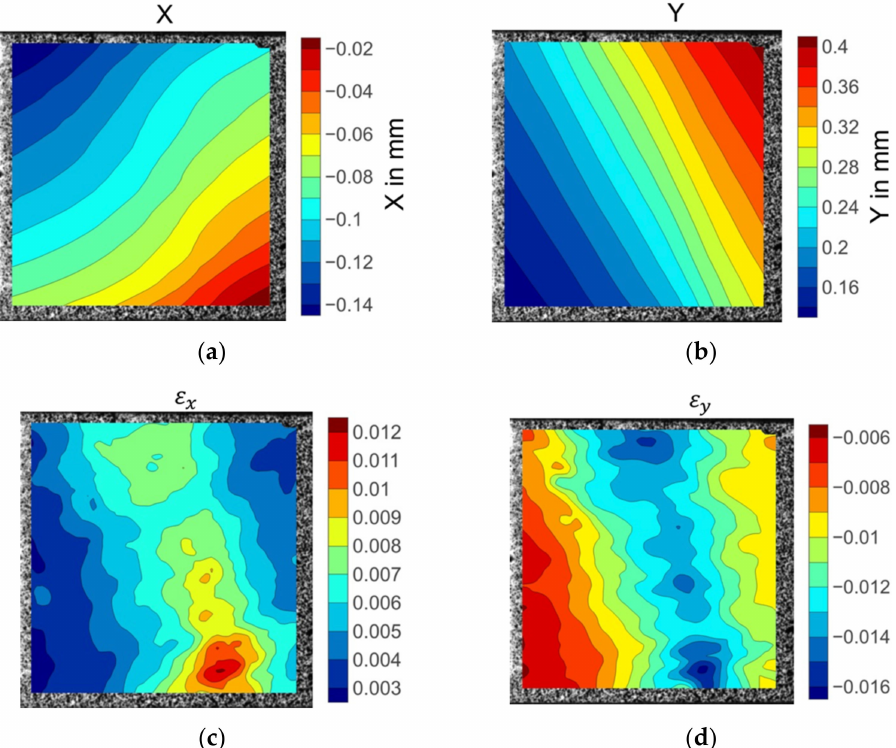
Figure 9. The displacement and strain field contour plots of the 15 ◦ off-axis specimen: ( a ) Displace- ment in the X direction; ( b ) displacement in the Y direction; ( c ) strain in the X direction; ( d ) strain in the Y direction.